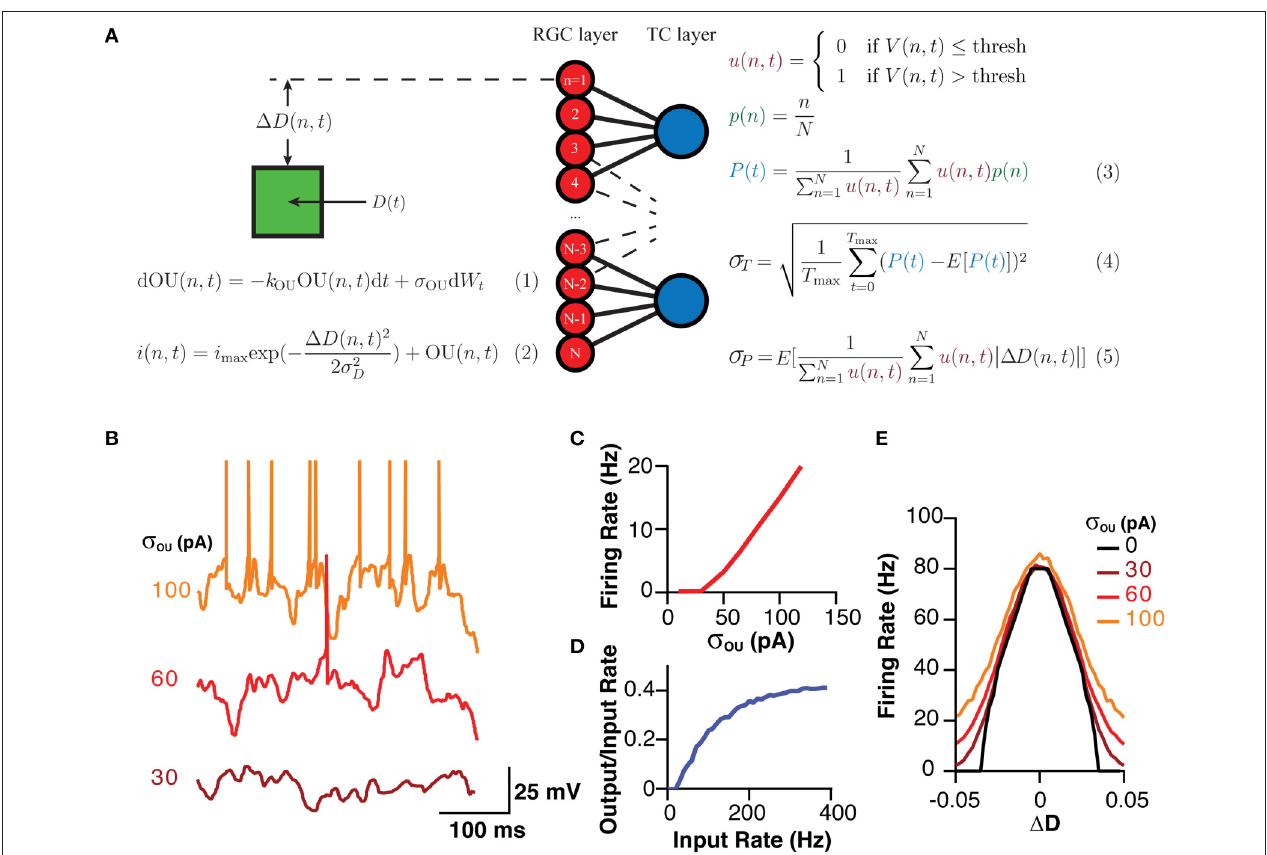
FIGURE 1 | A schematic of the model, the equations governing its behavior and its analysis and the model’s typical behavior. (A) A Schematic of the model and the fundamental equations dictating its behavior and analysis. Equation (1) produces the current noise while Equation (2) shows that the total current the membrane receives is the sum of the OU noise and a “sensory” current that is a Gaussian function of the difference between the cells position and stimuli. Equation (3) demonstrates how the estimator for the position of the stimuli was calculated. Equation (4) shows how σ T , which was used as a measure of the stability of the encoding over time, was calculated as the standard deviation of P(t). Equation (5) shows how σ P , a measure of the spatial accuracy of the encoding in the layer, was calculated. Note, color of equations is used to link similar terms. E[X] represented the expectation value of the expression X. (B) Representative examples of the membrane potential of RGCs in response to various amplitudes of OU noise. (C) The mean firing rate of an RGC in response to various amplitudes of OU noise. (D) The transfer function of TCCs, represented as the rate of retinogeniculate EPSPs against the ratio of the output (spiking rate) to the input (EPSP rate), showing the high-pass behavior of TCCs. (E) The sensory behavior of RGCs showing their firing rate as a function of the distance to the stimuli ( 1 D) and the amplitude of the OU